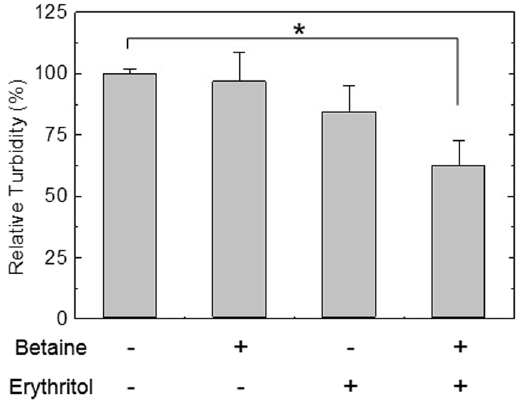
Figure 5. Relative turbidity of suspensions containing 1% water-insoluble polysaccharides isolated from S. mutans biofilms. 5.6 mM betaine and 2.8 mM erythritol were contained in DW. Each value and error bar indicates mean and SD, respectively ( n =